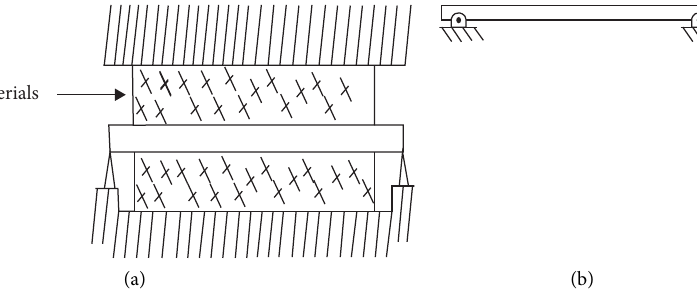
Figure 22: Displacement nonlinearity due to tangent type